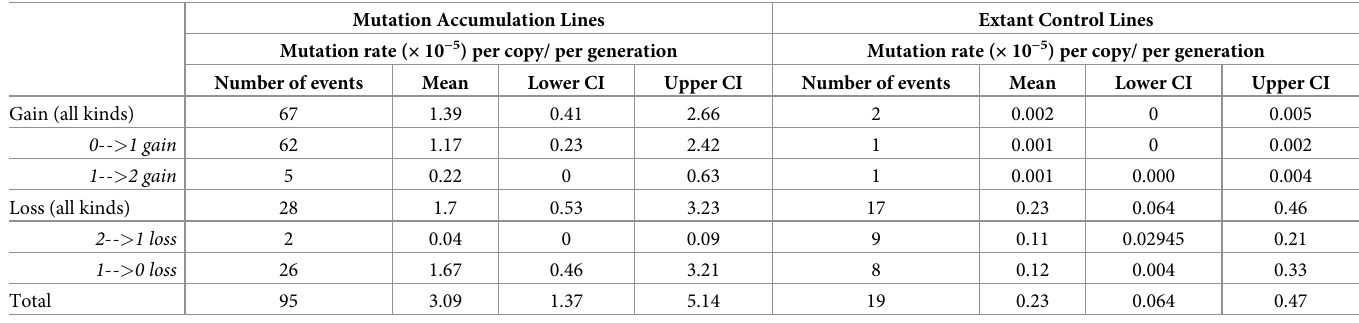
were not consistently higher in D . magna as one would predict (S12 Table), nor did they corre- late with known intraspecific variation in base substitution mutation rates within this species (S16 Fig; ρ = -0.66, t = -2.3, P = 0.055). 7 Estimated rates of TE loss and gain using mutation accumulation experiments We used mutation accumulation (MA) experiments initiated from each of the 9 genotypes of D . magna from each of the three populations to estimate overall (Tables 2 and S13) and family-spe- cific TE mutation rates (Table 3). Using whole genome sequence (WGS) data from the MA lines, we detected 67 gain and 28 loss mutations; S14 Table shows the location and read support for each event. Rates of gain across MA lines ranged from 0 to 22.6 x 10 − 5 per copy per generation with a mean rate of 1.39 x 10 − 5 /copy/gen (95% CI: 0.41 x 10 − 5 –2.66 x 10 − 5 ) and loss rates ranged Table 2. Number of events and mean TE mutation rates (per copy per generation, including 95% confidence intervals [CI]) for gains and losses based on whole genome sequence data from 66 Daphnia magna mutation accumulation and extant control lines descended from 9 starting genotypes collected from Finland, Ger- many, and